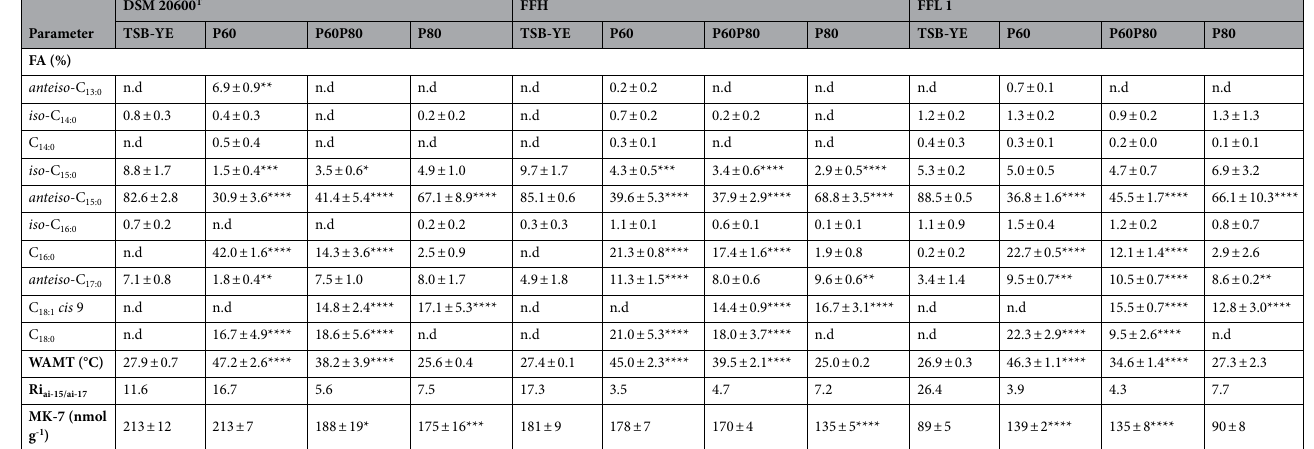
Table 1. Fatty acid (FA) composition, weighted-average melting temperature (WAMT), the ratio of anteiso -C 15:0 to anteiso -C 17:0 (Ri ai-15/ai-17 ), and menaquinone-7 (MK-7) content. Listeria monocytogenes strains DSM 20600 T , FFH, and FFL 1 grown at 6 °C in tryptic soy broth-yeast extract medium without supplementation (TSB-YE), with 0.1% (wt/vol) polysorbate 60 (P60), with 0.05% (wt/vol) each of polysorbate 60 and polysorbate 80 (P60 P80), and with 0.1% (wt/vol) polysorbate 80 (P80). Values are means ± standard deviation ( n = 3). Asterisks represent p values (* p < 0.001, ** p < 0.0001, *** p < 0.00001, **** p < 0.000001) compared to cultures in TSB-YE without